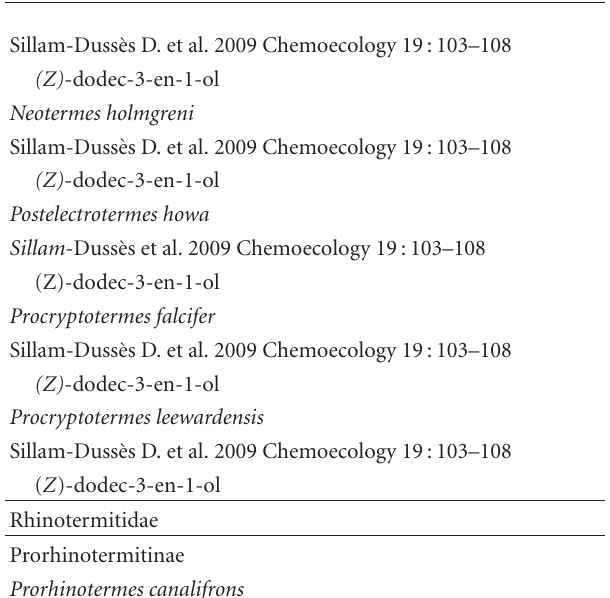
Table 2: Chemical compounds reported from trail pheromones of termites. All data were extracted from Pherobase [1], and from Bordereau and Pasteels